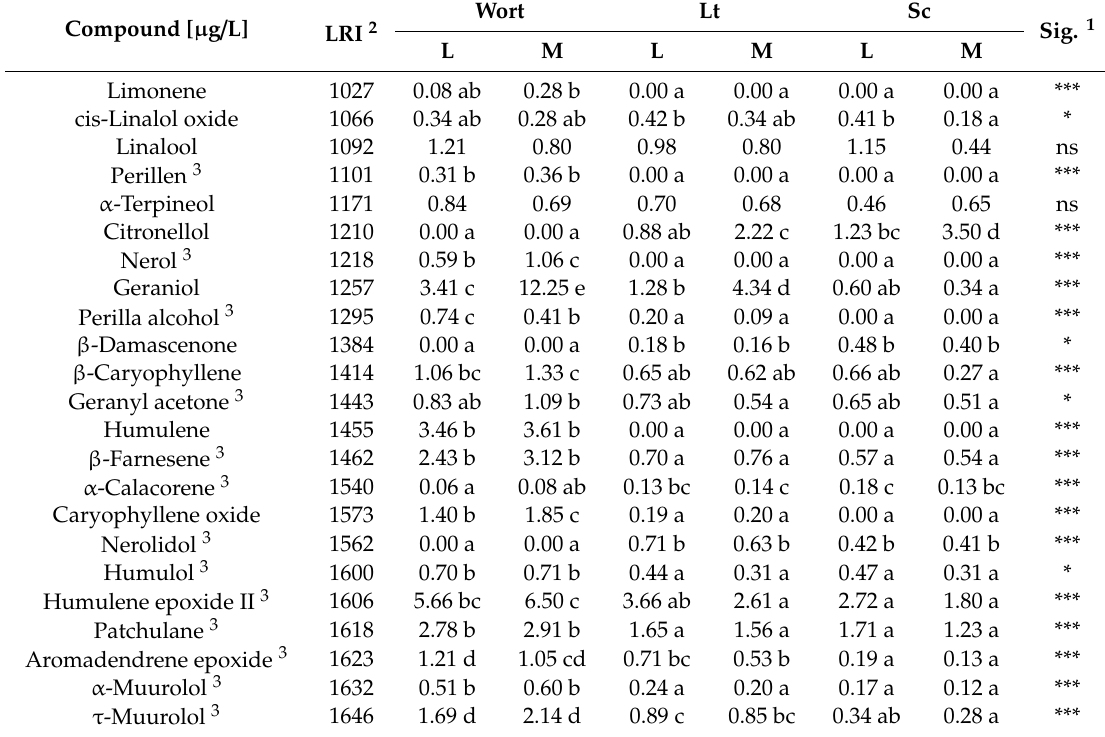
Table 5. Terpenes in hopped wort and beer brewed with Marynka (M) or Lubelski (L) hop pellets, fermented by L. thermotolerans (Lt) or S. cerevisiae (Sc). Compound [ µ g / L] LRI 2